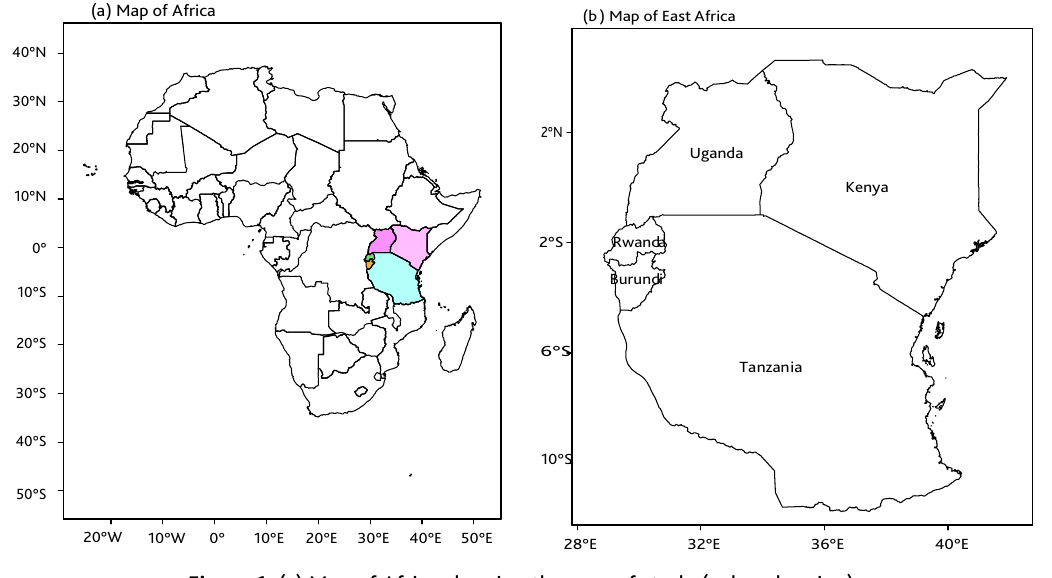
Figure 1. (a) Map of Africa showing the area of study (colored region) (b) Map of East Africa showing countries used in this study